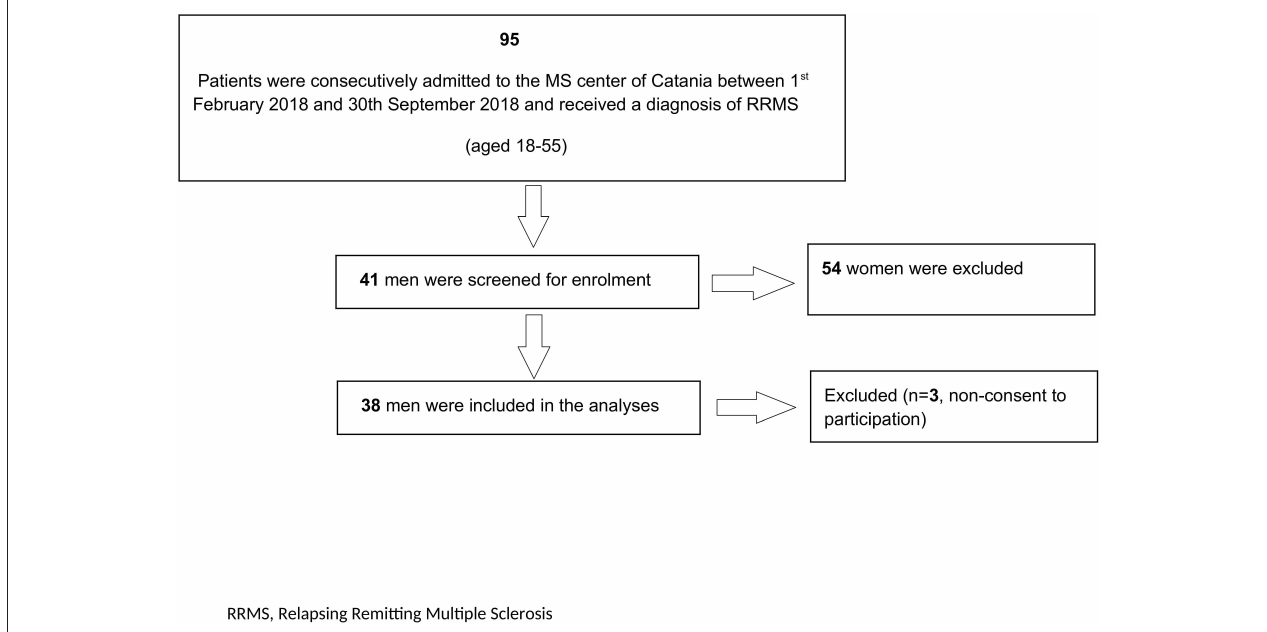
FIGURE 1 | Patients’ selection flow chart. RRMS, relapsing remitting multiple